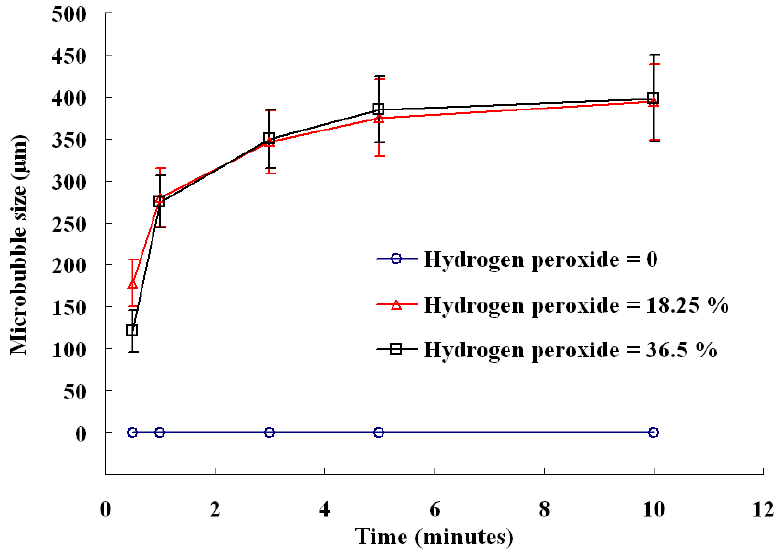
Figure 3. Evolution of microbubble size in alginate particles under the conditions of Figure 2.